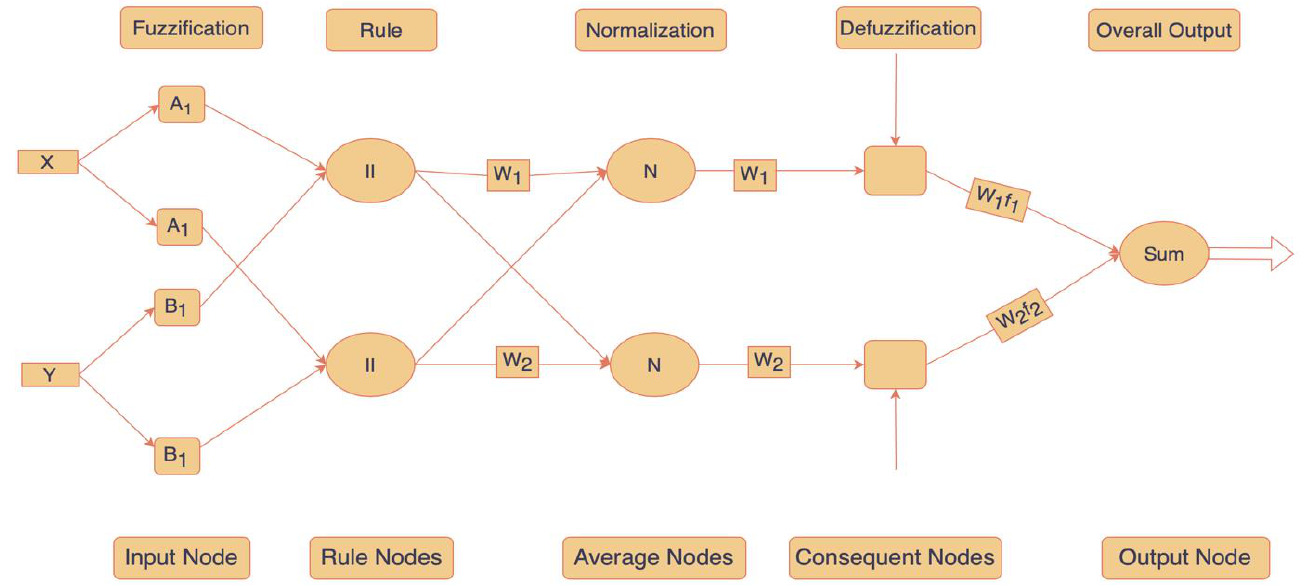
Figure 2. Schematic diagram of a fuzzy inference system.